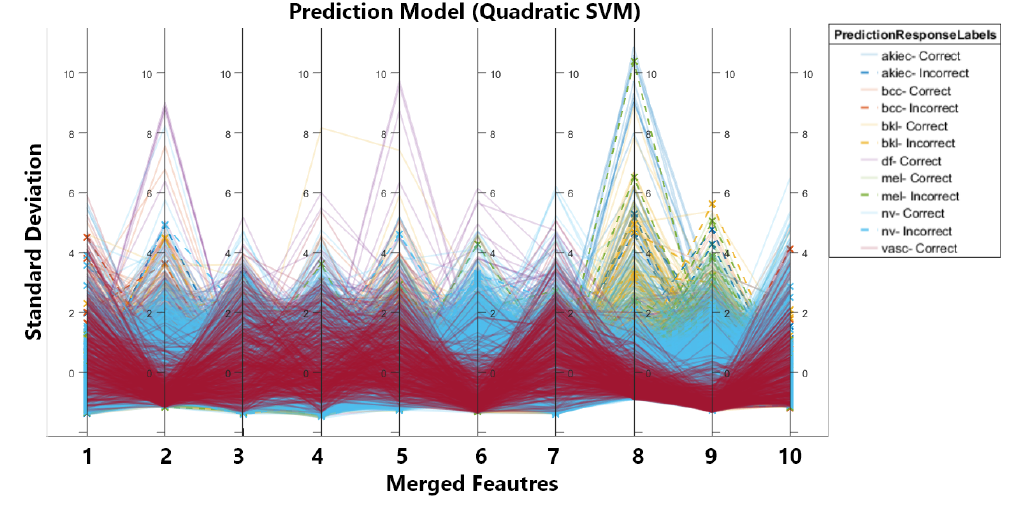
Figure 3. Parallel Co-ordinates